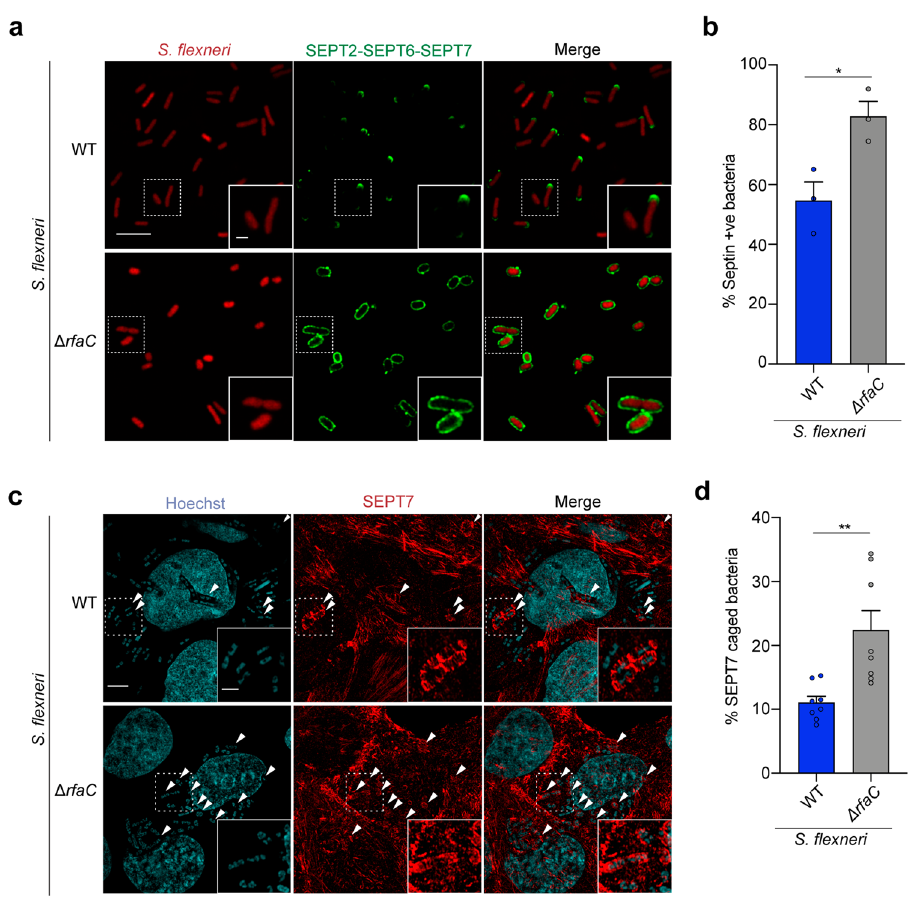
Fig. 4 Lipopolysaccharide protects S. fl exneri from septin cage entrapment. a Representative Airyscan confocal images showing the binding of septins in vitro to S. fl exneri (WT, top) or Δ rfaC (O-antigen – , bottom). Scale bar, 5 μ m (inset, 1 μ m). b Percentage of bacteria recruiting septins in vitro. Quanti fi cations represent mean ± SEM from n = 895 (WT), n = 689 ( Δ rfaC ) S. fl exneri cells distributed in 3 independent experiments. * p = 0.0249 by two- tailed Student ’ s t -test. c Airyscan confocal images of HeLa cells infected for 3 h 40 min with S. fl exneri str. afaE (WT, top) or S. fl exneri Δ rfaC (bottom) and stained for SEPT7 and Hoechst. SEPT7 cages are indicated with arrowheads. S. fl exneri afaE strain (hyperinvasive) was used to compare WT infection to S. fl exneri Δ rfaC . Scale bar, 5 μ m (inset, 2 μ m). d Percentage of septin caged bacteria in HeLa cells infected for 3 h 40 min. Data represent the mean ±